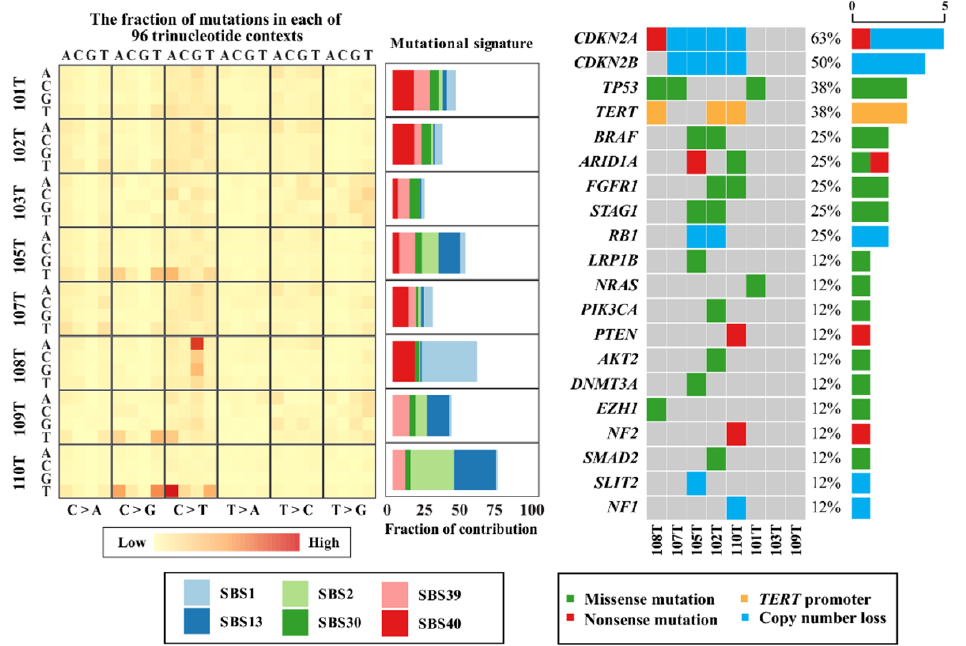
Figure 1. Main mutational signatures and aberrations in cancer-related genes of anaplastic thyroid carcinoma (ATC). Left: The single nucleotide variant (SNV) composition across the ATC cohort is visualized, depicting a general overrepresentation of C > T transitions. Single base substitution (SBS) signatures as defined by the Catalogue of Somatic Mutations in Cancer (COSMIC) mutational signatures are also shown, displaying an enrichment of SBS2 and SBS13 profiles characterized by the activity of Apolipoprotein B mRNA-editing enzyme, catalytic polypeptide-like (APOBEC) family of cytidine deaminases. Right: Gene aberrancy heatmap of the ATC cohort highlighting events in the top 20 mutated genes in ATC according to the COSMIC database, with frequencies in the right-most bar chart. CDKN2A was the most commonly affected gene, with four cases exhibiting copy number loss and an additional case with a nonsense mutation. Cases T103 and T109 did not harbor any events among the top 20 mutated genes in ATC according to the COSMIC database but had numerous other genetic aberrations not displayed